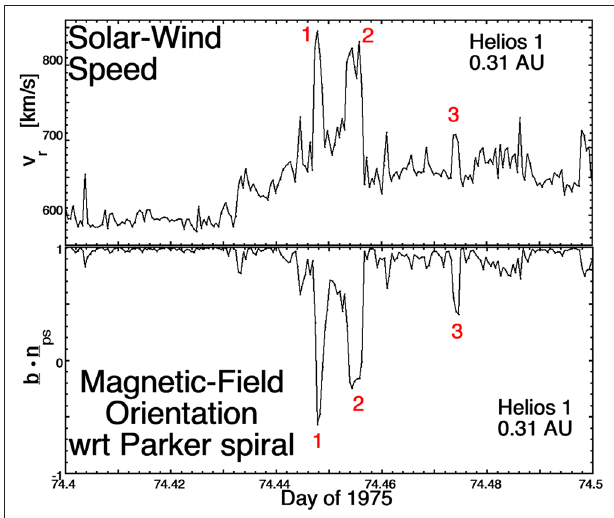
FIGURE 5 | Magnetic switchbacks (labeled 1, 2, and 3) and the associated solar-wind-velocity pulses at 0.31AU. The curves are 40-s resolution measurements by Helios 1 [cf. Fig. 11 of Borovsky (2016)].